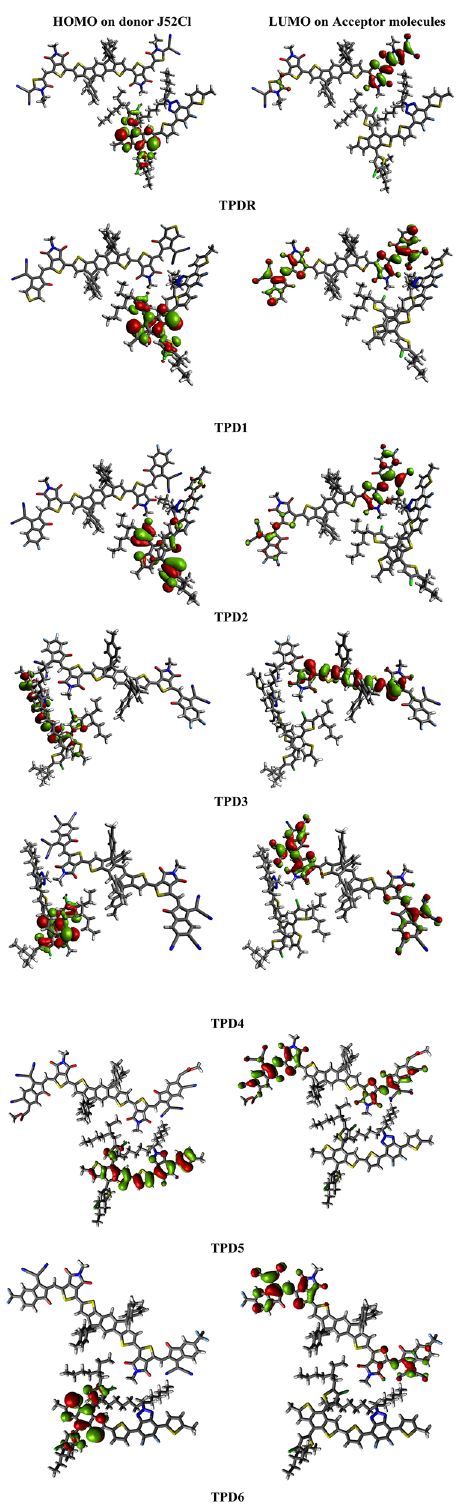
Figure 8. Charge transfer between HOMO J 52 Cl and LUMO of investigated molecule ( TPDR and TPD1 – TPD6 ) drawn with the help of Avogadro software, Version 1.2.0. (http:// avoga dro. cc/). All out put files of entitled compounds were accomplished by Gaussian 09 version D.01 (https:// gauss ian. com/ g09ci